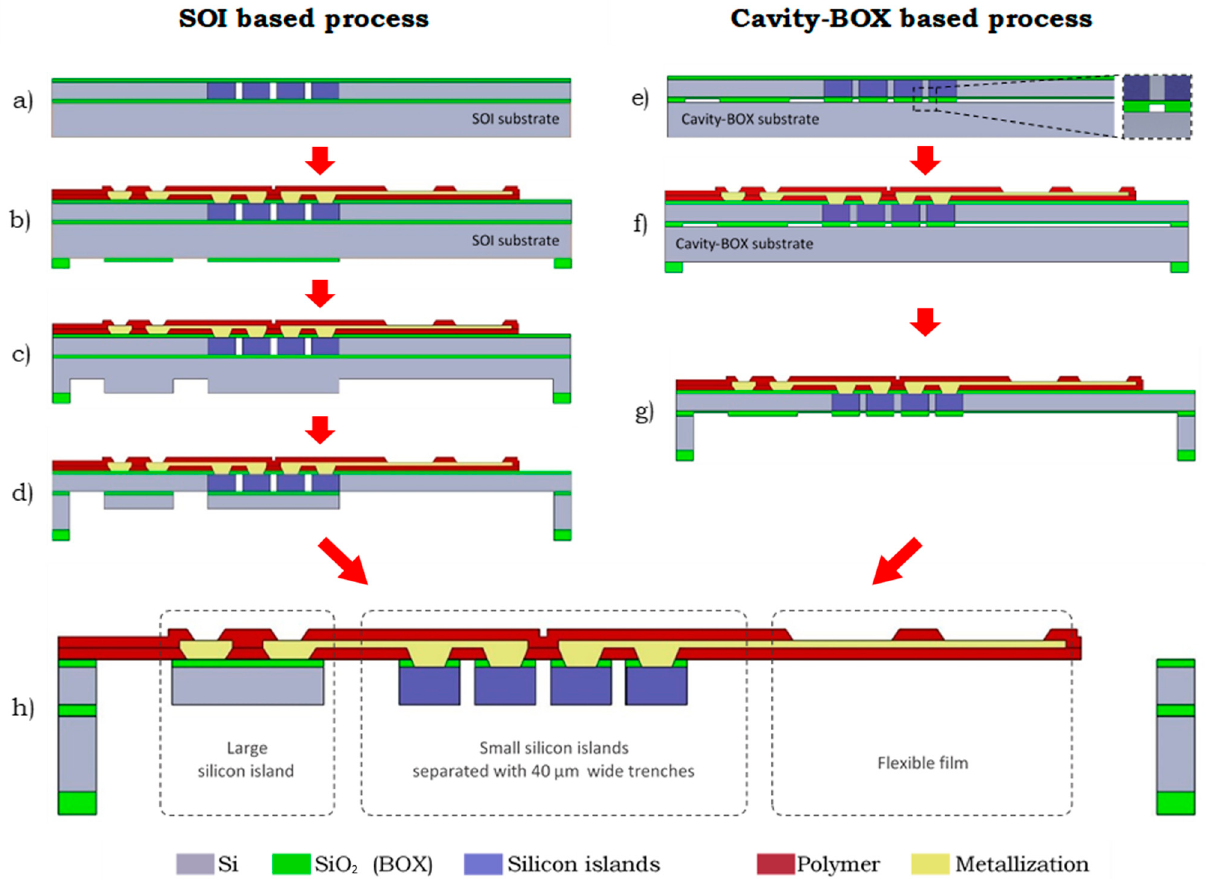
Figure 2. Simplified manufacturing process flow diagrams of semiflexible DBS device using the trench-based F2R technology versus using cavity-BOX substrate. Left ( a – d ): The SOI based process with sealed trenches on the front side of the wafer and a two-step backside etch process. Right ( e – g ): The cavity-BOX based process using patterned BOX as an etch-stop layer and hard-etch mask. Bottom ( h ): Finished device.